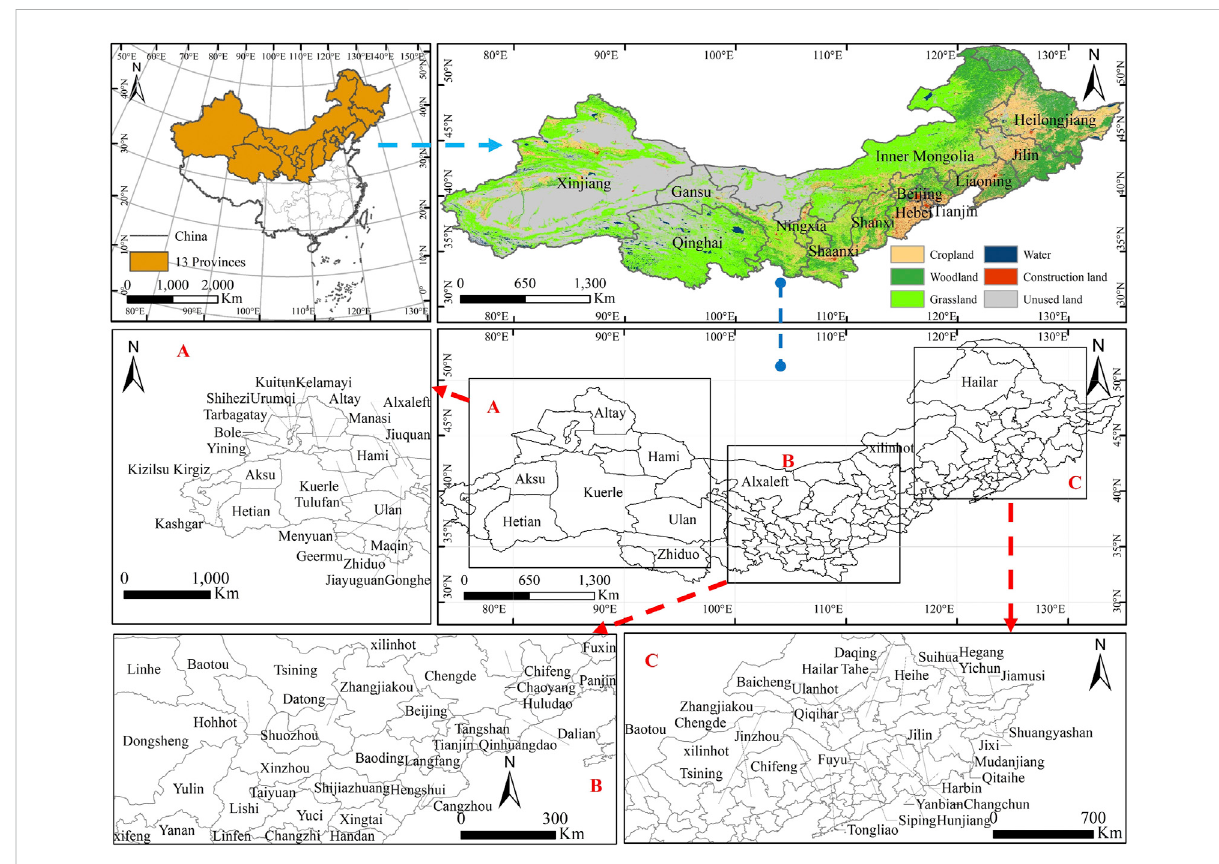
FIGURE 1 Mapofstudyarea.Note:Arepresentsthewesternpartofthestudyarea,Brepresentsthecentralpartofthestudyarea,Crepresentstheeastern part of the study